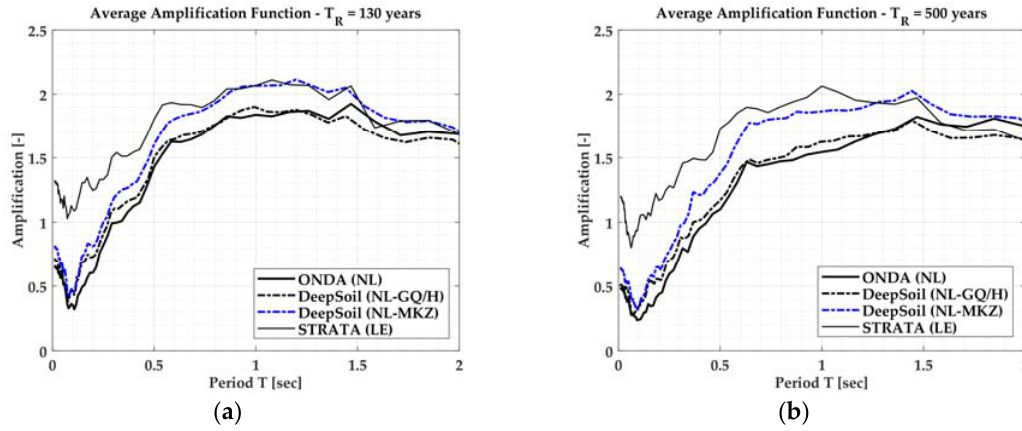
Figure 17. Average surface ‐ to ‐ bedrock amplification function: ( a ) RP = 130 years; ( b ) RP = 500 years.